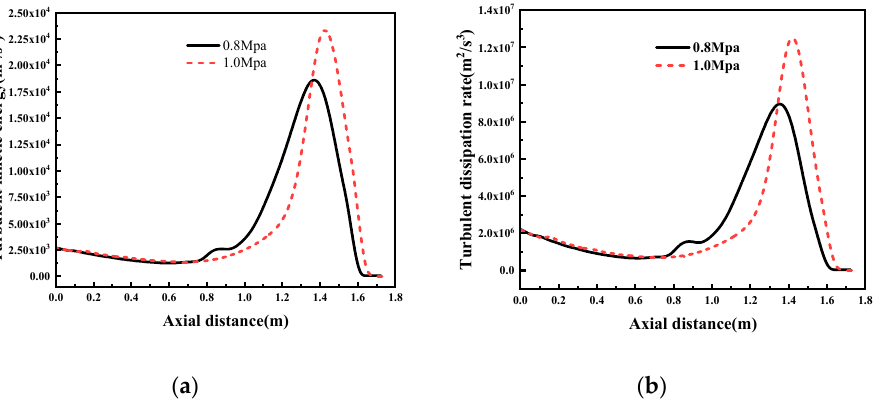
Figure 12. Radial distributions of turbulence kinetic energy of cyclone nozzle at different axial locations under different operating pressure and lance height of 1100 mm: ( a ) 0.4 m from nozzle exit; ( b ) 1.1 m from nozzle exit (interface between oxygen and slag).